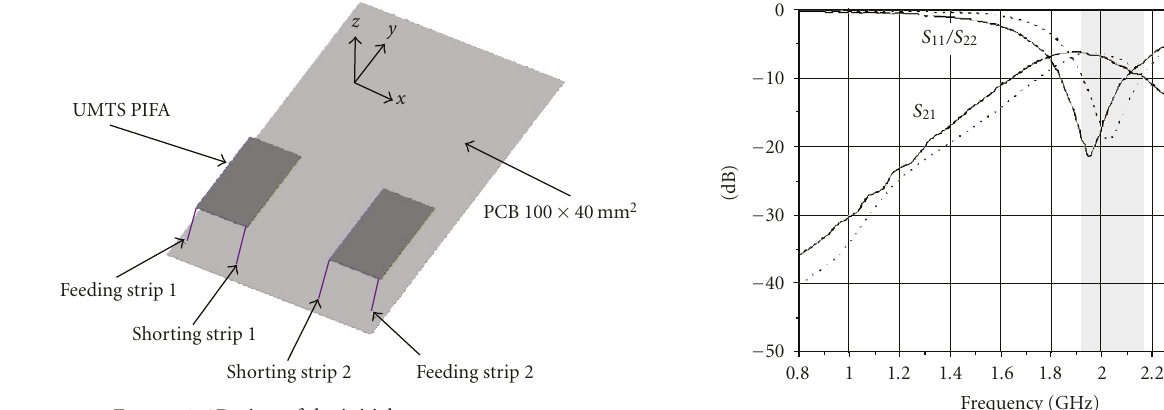
Figure 1: 3D view of the initial two-antenna system.